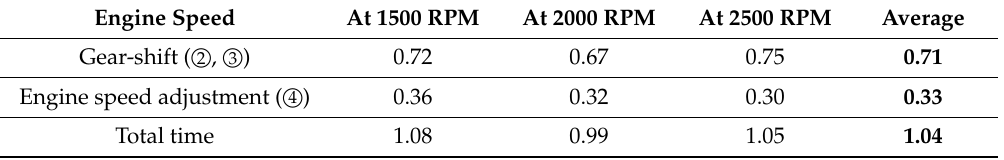
Table 4. Elapsed times for shifting from even to odd gear-stage (from 2nd to 3rd) (Unit: second). Engine Speed At 1500 RPM At 2000 RPM At 2500 RPM Average Gear-shift ( 2 (cid:79) , 3 (cid:79) ) 0.72 0.67 0.75 0.71 Engine speed adjustment ( 4 (cid:79) ) 0.36 0.32 0.30 0.33 Total time 1.08 0.99 1.05